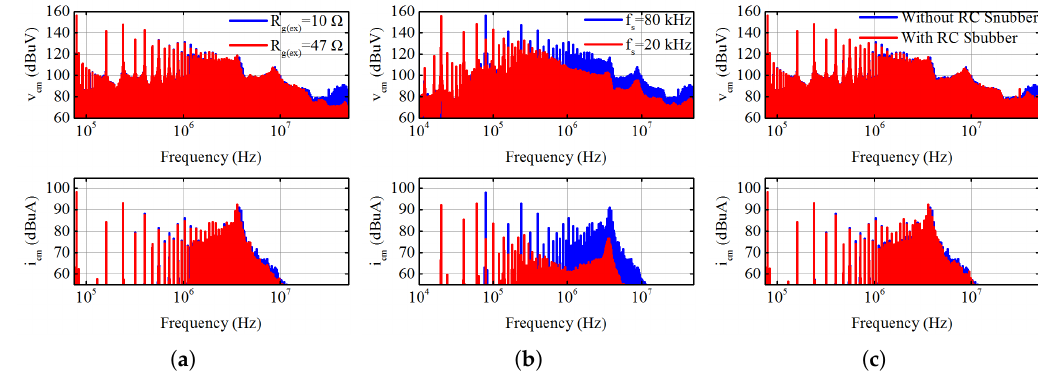
Figure 27. Spectra of CM voltage and CM current: ( a ) R g ( ex ) = 10 and 47 Ω , ( b ) f s = 80 and 20 kHz, ( c ) with and without RC